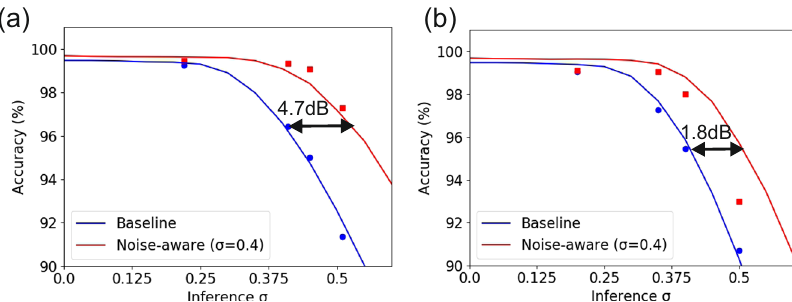
Fig. 5 | noise-aware training: simulation vs experiment. Accuracy on MNIST classi fi cation task versus noise standard deviation at a 5 and b 10GMAC/sec/axon.